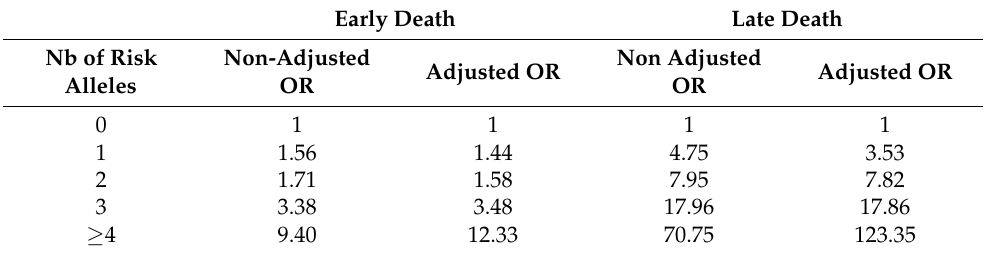
Table 2. Adjusted and unadjusted OR for cumulative effect of allele risk at leader SNPs. Early Death Late Death Nb of Risk Alleles